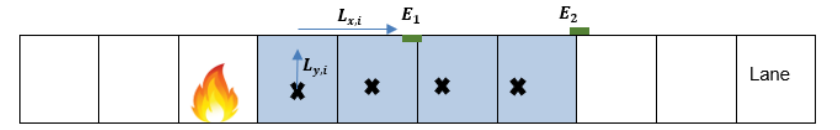
Figure 3. C 1,1 escape path based on the initial position adopted from [24]. Figure 5 appears below: